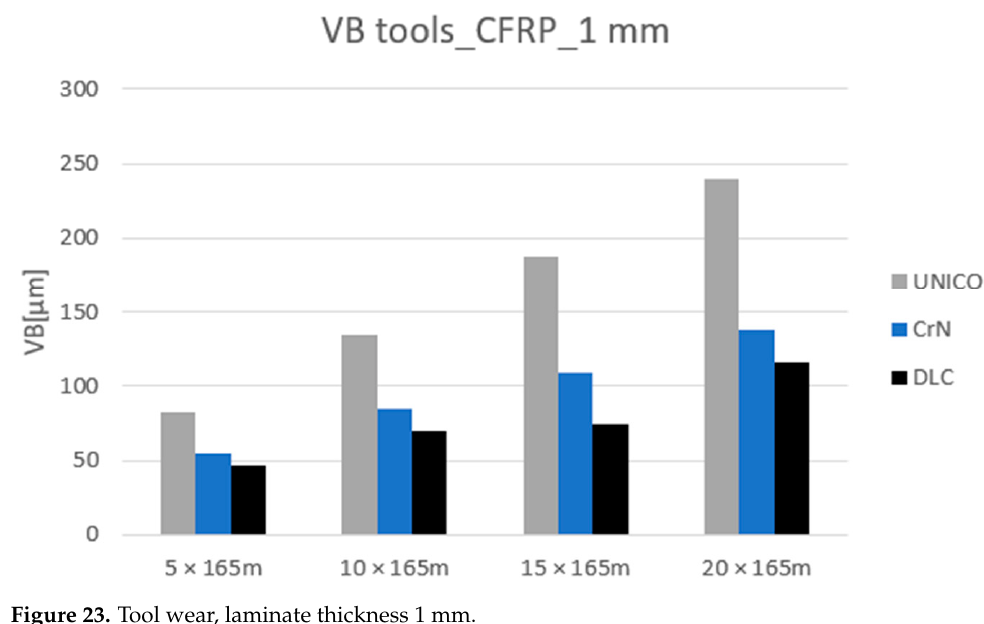
Figure 23. Tool wear, laminate thickness 1 mm.